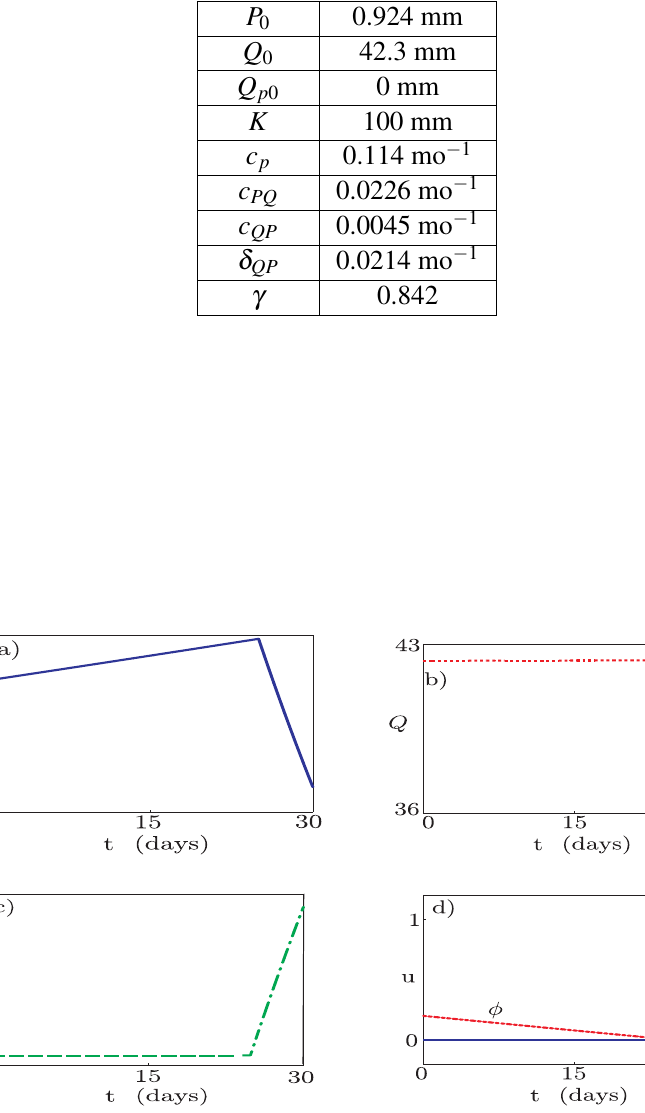
Fig. 7 Optimal solution for functional J w ( u ) in (29) with w = 0 and total dose M = 5; the time horizon is 30 days. Top row : a) proliferative cells P , b) nonproliferative quiescent cells Q ; Bottom row : c) damaged quiescent cells Q p , d) optimal control u ∗ ( t ) and switching function φ